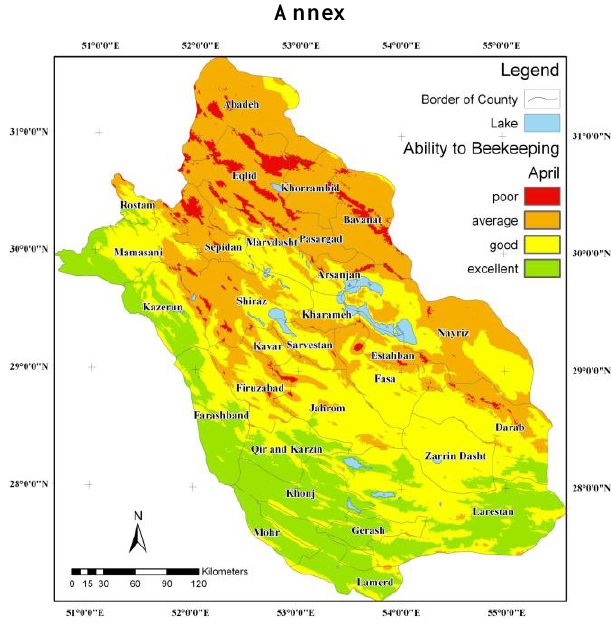
Fig. 1. Suitability of climate conditions for beekeeping in April.